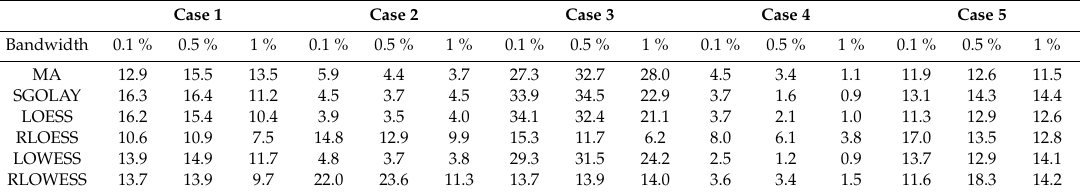
Table 7. Normalized RMSE between smoothed data and filtered data of Wulilin Bridge. Case 1 Case 2 Case 3 Case 4 Case 5 Bandwidth 0.1